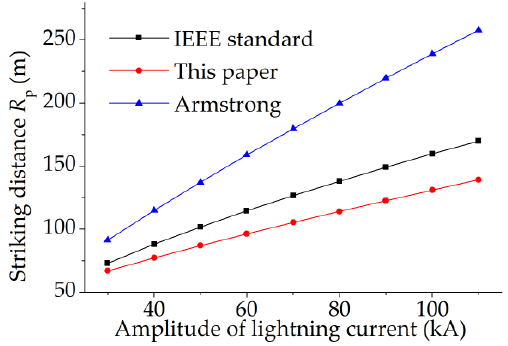
Figure 6. Striking distances obtained by different methods.